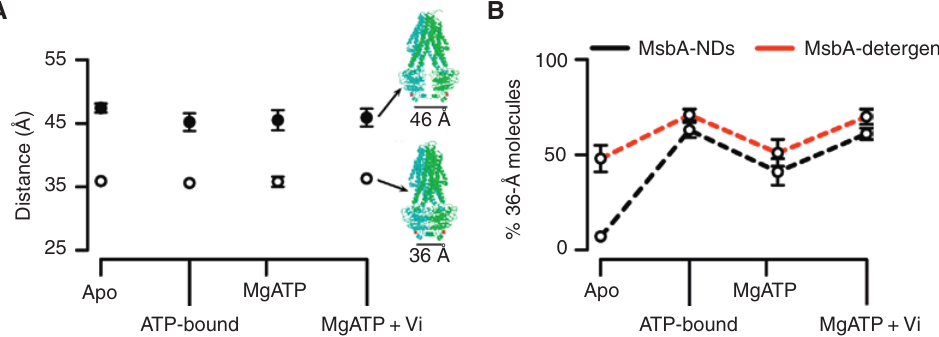
Figure 6: Comparison of MsbA in nanodiscs with MsbA in detergent. (A) Donor-acceptor distances of MsbA in nanodiscs during the hydrolysis cycle. Distances calculated in different states during the hydrolysis cycle from the LRET sensitized Bodipy FL emission decays in MsbA-NDs (means ± SD). Possible MsbA structures associated with each distance are shown on the right with the monomers in the MsbA homodimer shown in blue and cyan; the position of the labeled Cys-561 is shown in red. (B) Percentage of MsbA molecules with associated nucleotide-binding domains during the hydrolysis cycle (MsbA molecules displaying the shorter distance; ~ 36 Å). Data are means ± SD. The experimental conditions were: apo, nucleotide-free state obtained in nominally divalent cation-free buffer with 1 mM EDTA to chelate trace divalent cations and prevent ATP hydrolysis; ATP-bound, ATP-bound state obtained after the addition of 1 mm NaATP; MgATP, continuous hydrolysis state obtained after the addition of 10 mm MgSO ; and MgATP + Vi, high-energy posthydrolysis state obtained by the addition of 4 0.25 mm orthovanadate in the presence of MgATP. Modified from Zoghbi et al.